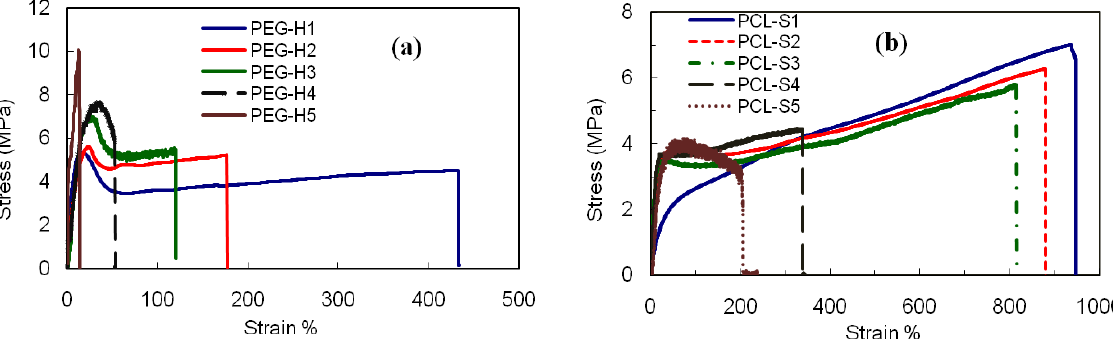
Figure 6. Summary of elongation at break ( a ) and maximum stress ( b ) for PEG and PCL SMPUs, respectively, at ambient